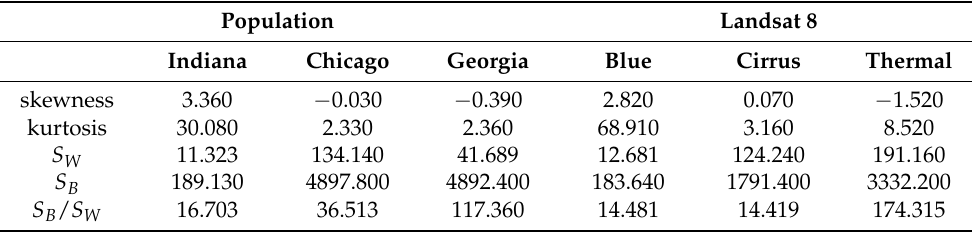
Table 3. Fisher’s linear discriminant, including S W , S B , and S B / S W , of the GIC classification results in terms of skewness and kurtosis of the population data and remote sensing images. Population Landsat 8 Indiana Chicago Georgia Blue Cirrus Thermal skewness